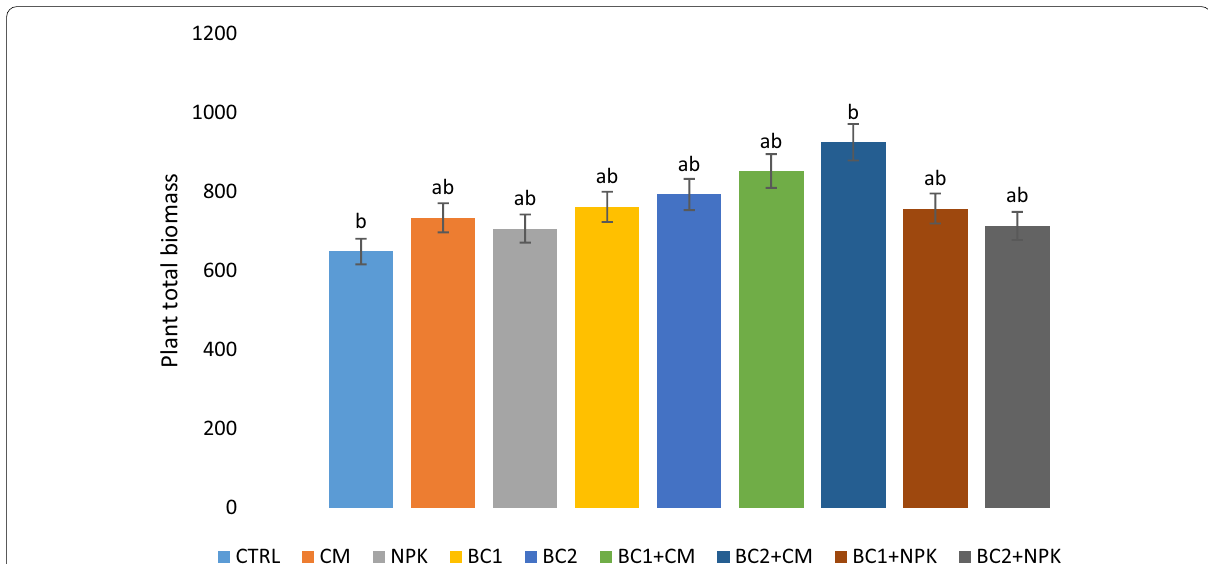
Fig. 4 Residual Effect of biochar, farmyard manure compost and/or NPK on the fresh total collard plant biomass. The same letter on the bars are not significantly different at p 0.0 5 using Tukey HSD; Control(CTRL), 10 t/ha compost only (CM), 200 kg NPK (NPK), 10t/ha Biochar only (BC1), 20 ≤ t/ha Biochar only (BC2), 5 t/ha Biochar 5 t/ha compost (BC1 CM), 10 t/ha Biochar 5 t/ha compost (BC2 CM), 5t/ha Biochar 100 kg/ha NPK + + + + + (BC1 NPK), 10 t/ha Biochar 100 kg/ha NPK (BC2 NPK); Error bars represent standard deviation of the + + +